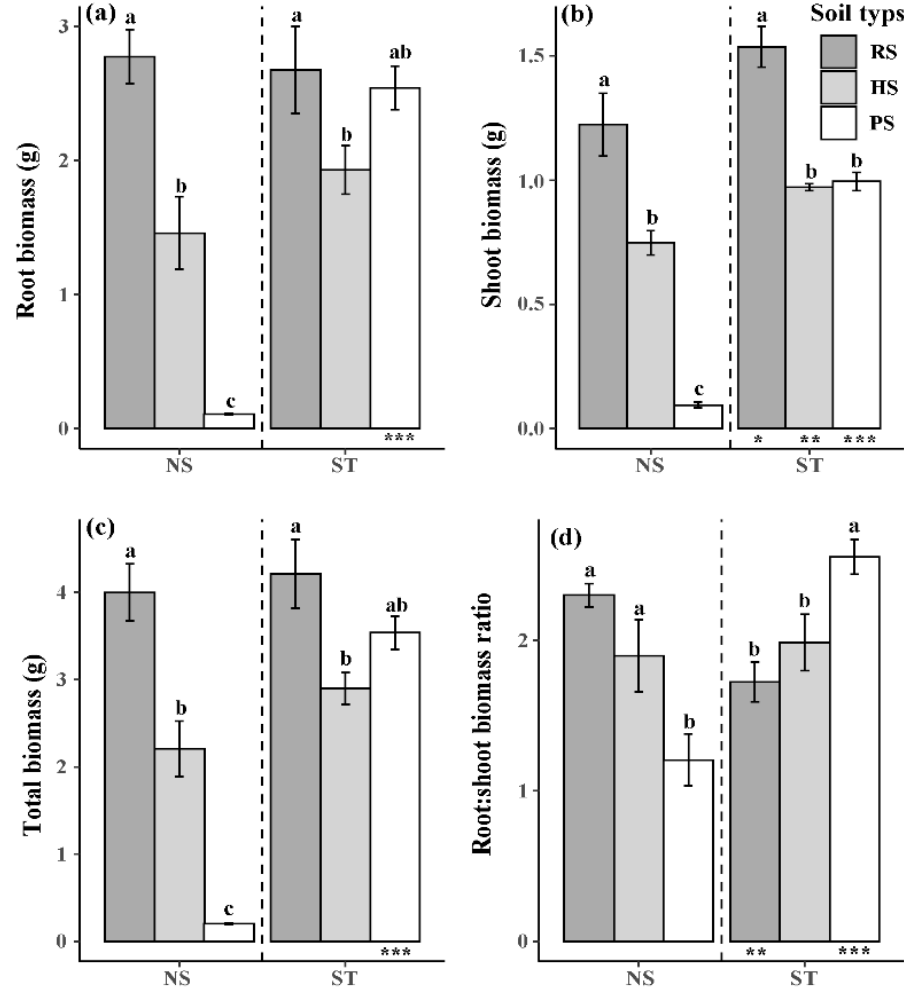
Figure 1. Effects of different soils on plant biomass and biomass allocation in R. nepalensis . ( a ) root biomass; ( b ) shoot biomass; ( c ) total biomass; ( d ) root to shoot biomass. Bars show the mean values; error bars represent ± SEs (n = 5). Different letters above the error bars indicate significant differences ( p < 0.05) among the various soil types (RS, R. nepalensis soil; HS, H. rhamnoides soil; PS, P. asperata soil). Asterisks under the bars represent significant differences in plant growth in nonsterile (NS) versus sterile (ST) soil according to a t -test (*, 0.01 < p < 0.05; **, p < 0.01; ***, p < 0.001).